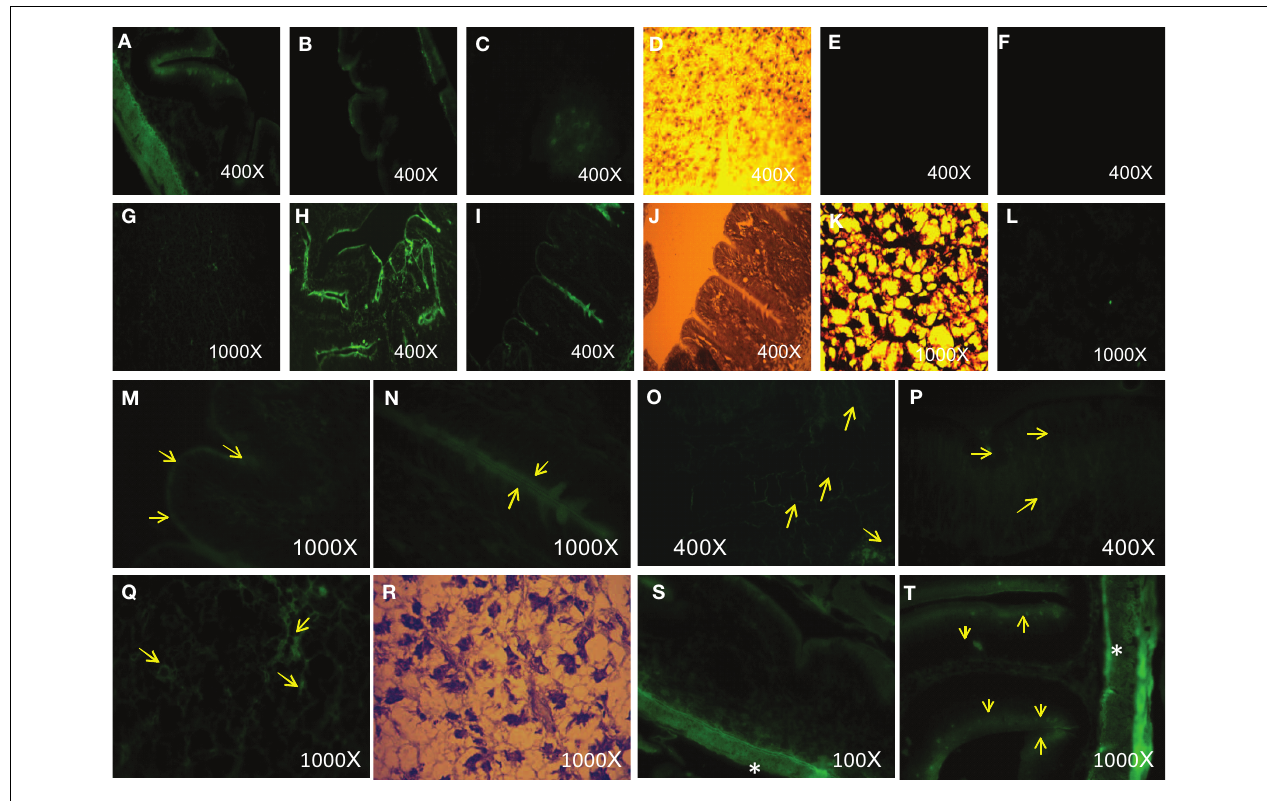
FIGURE 4 | (A,B) AgNPs with compound 1 in fish intestine: green fluorescence. THF: In fish intestine (E) and liver (F) : no fluorescence visible. (C) AgNPs with compound 1 in fish liver: green fluorescence. (D) Bright field optical microscopy of liver (same spot of C ). (G,L) AgNPs with compound 2 in fish liver: green fluorescence. (I,H) AgNPs with compounds 2 in fish intestine: green fluorescence. (K,J) Bright